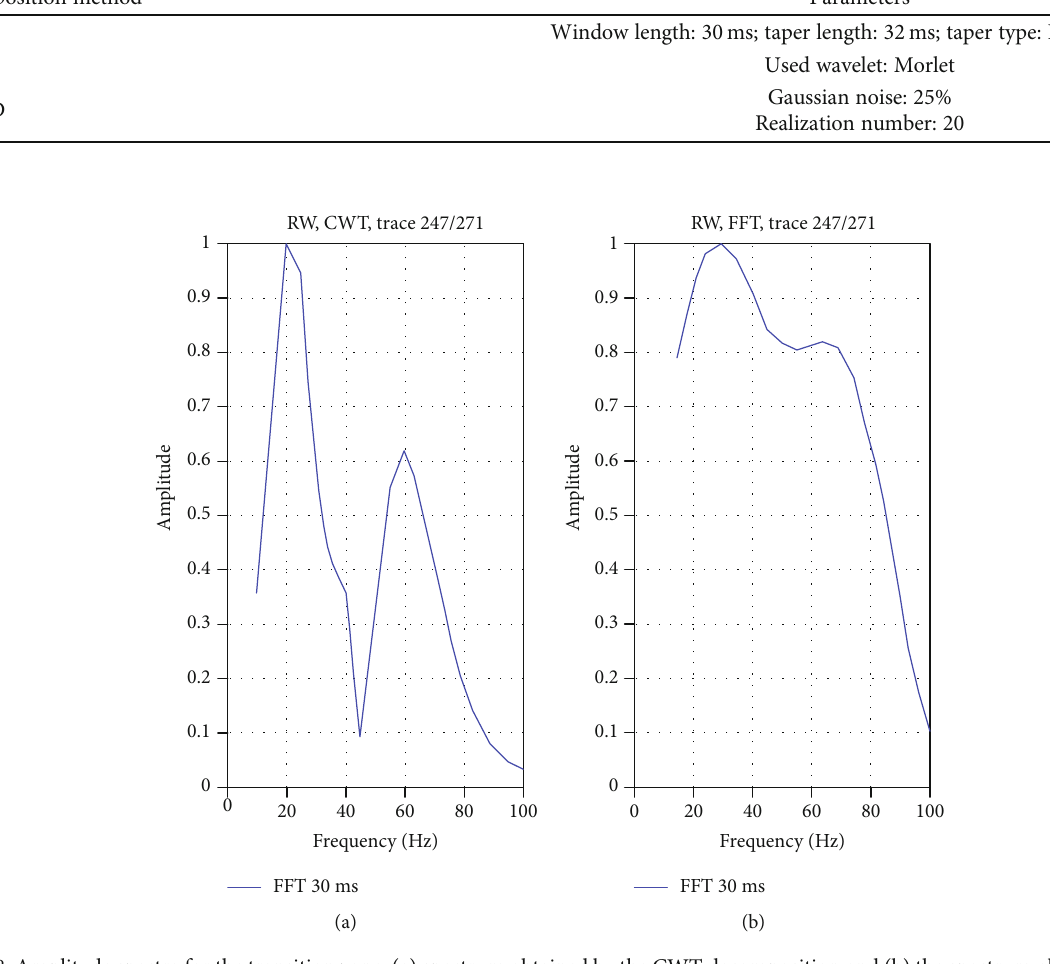
Figure 8: Amplitude spectra for the transition zone: (a) spectrum obtained by the CWT decomposition and (b) the spectrum obtained by the FFT decomposition. Both spectra are shown for the same time